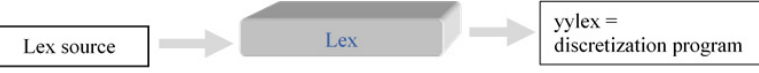
Fig. 1. Using Lex to produce the discretization program (step 1).